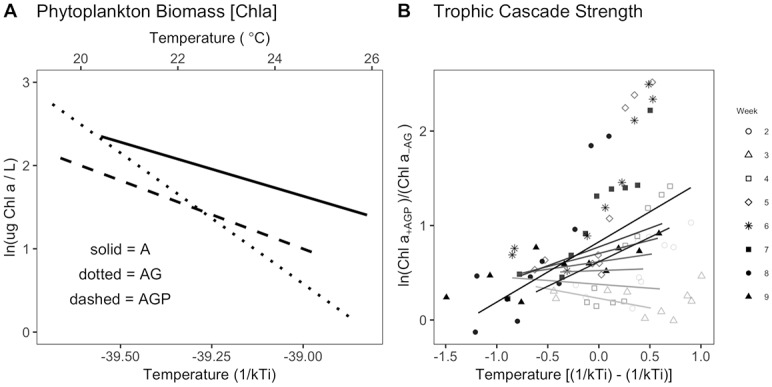
(A) Estimated phytoplankton biomass (chlorophyll a concentration) declined with increasing temperature and varied with trophic structure (A, AG, AGP). Lines are estimated effects of temperature on phytoplankton biomass based on LMMs (Eq 12) for Eq 3, with temperature dependence in model terms for the intercept and slope (Table 1). From the best model, the intercept and slope of each line were estimated by pooling terms for the intercept and temperature dependence in Eq 12 (see Methods, Eq 14). All observations for phytoplankton biomass are shown in Fig 6. (B) Strength of the trophic cascade at a given temperature was estimated by taking the log ratio of algal biomass (estimated as chlorophyll a concentration) in the presence of predators and grazers (AGP) versus the algal abundance in the presence of grazers only (AG) (Eq 4, Table 2). Lines represent fixed effects of temperature from the full model (Table 2), centered on the grand mean of all recorded ecosystem temperatures (Eq 13). Gray shading and symbols indicate the week, from week 2 (July 10) to week 9 (August 28), 2012. Data for these figures may be found at https://doi.org/10.5281/zenodo.2652579 in GarzkeAllwks.csv. A, algae only; AG, algae and grazers; AGP, algae, grazers, and predators; Chla, chlorophyll a; LMM, linear mixed effects model.